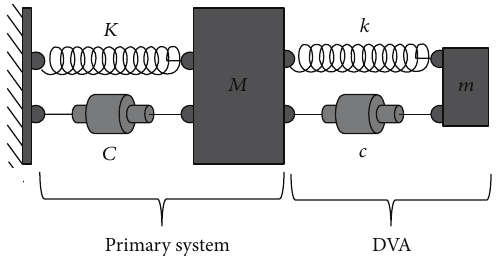
Figure 6: Classical DVA